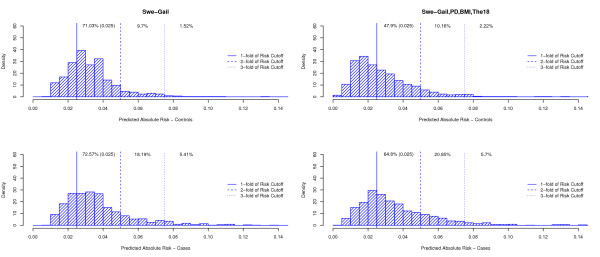
Distributions of estimated absolute risk by case-control status using the Swe-Gail model and the full model (with displayed proportions of women with five-year absolute risks greater than (multiples of 2.5%).